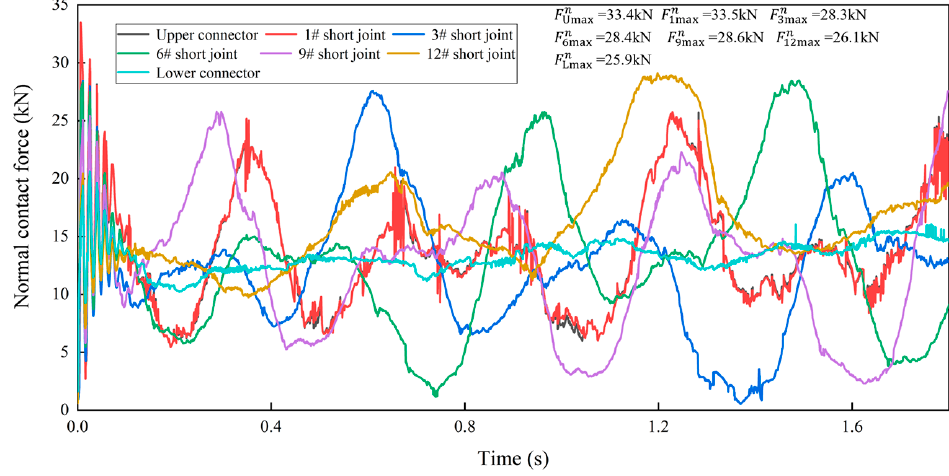
Figure 12. Normal contact force between upper and lower connectors and ball key, and 1#, 3#, 6#, 9#, 12# flexible drill pipe and ball key.